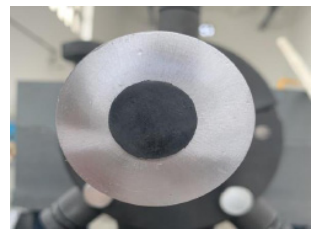
Figure 5. Waveform shaper. Figure 5. Waveform